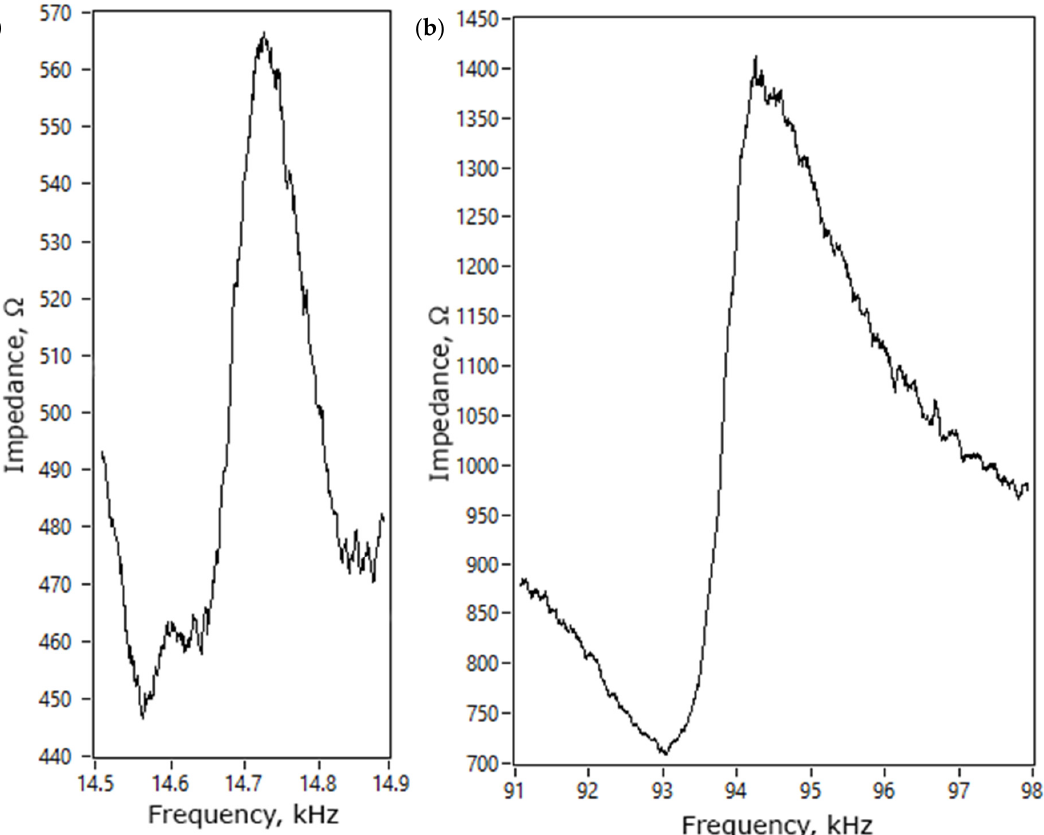
Figure 14. Impedance of the robot in the frequency domain for the first bending mode of the trapezoidal cantilever ( a ) and the third radial mode of the piezoceramic ring ( b ). The next step of the experimental investigation was to measure the planar and angu- lar speed of the robot. Supplementary Materials Videos S1 and S2 represents robot oper- ation. The experimental setup was built for this purpose (Figure 15). The experimental setup included a computer, a function generator WW5064 (Tabor Electronics, Nesher, Is- rael), a power amplifier PD200X4 (Piezo Drive, Shortland, Australia), oscilloscope DL2000 (Yokogawa, Tokyo, Japan), a displacement sensor ILD 2300 (Micro-Epsilon, Ortenburg, Germany), tachometer DT210 (Nidec-Shimpo, Tokyo, Japan) and self-made switch boxes.